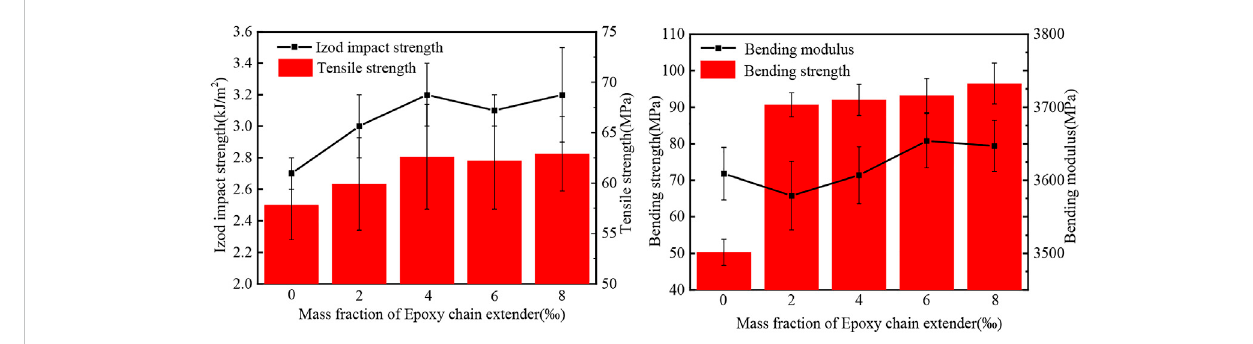
FIGURE 11 Mechanical properties mapping of PLA/P-PPD-Ph/ECE fl ame retardant composites.